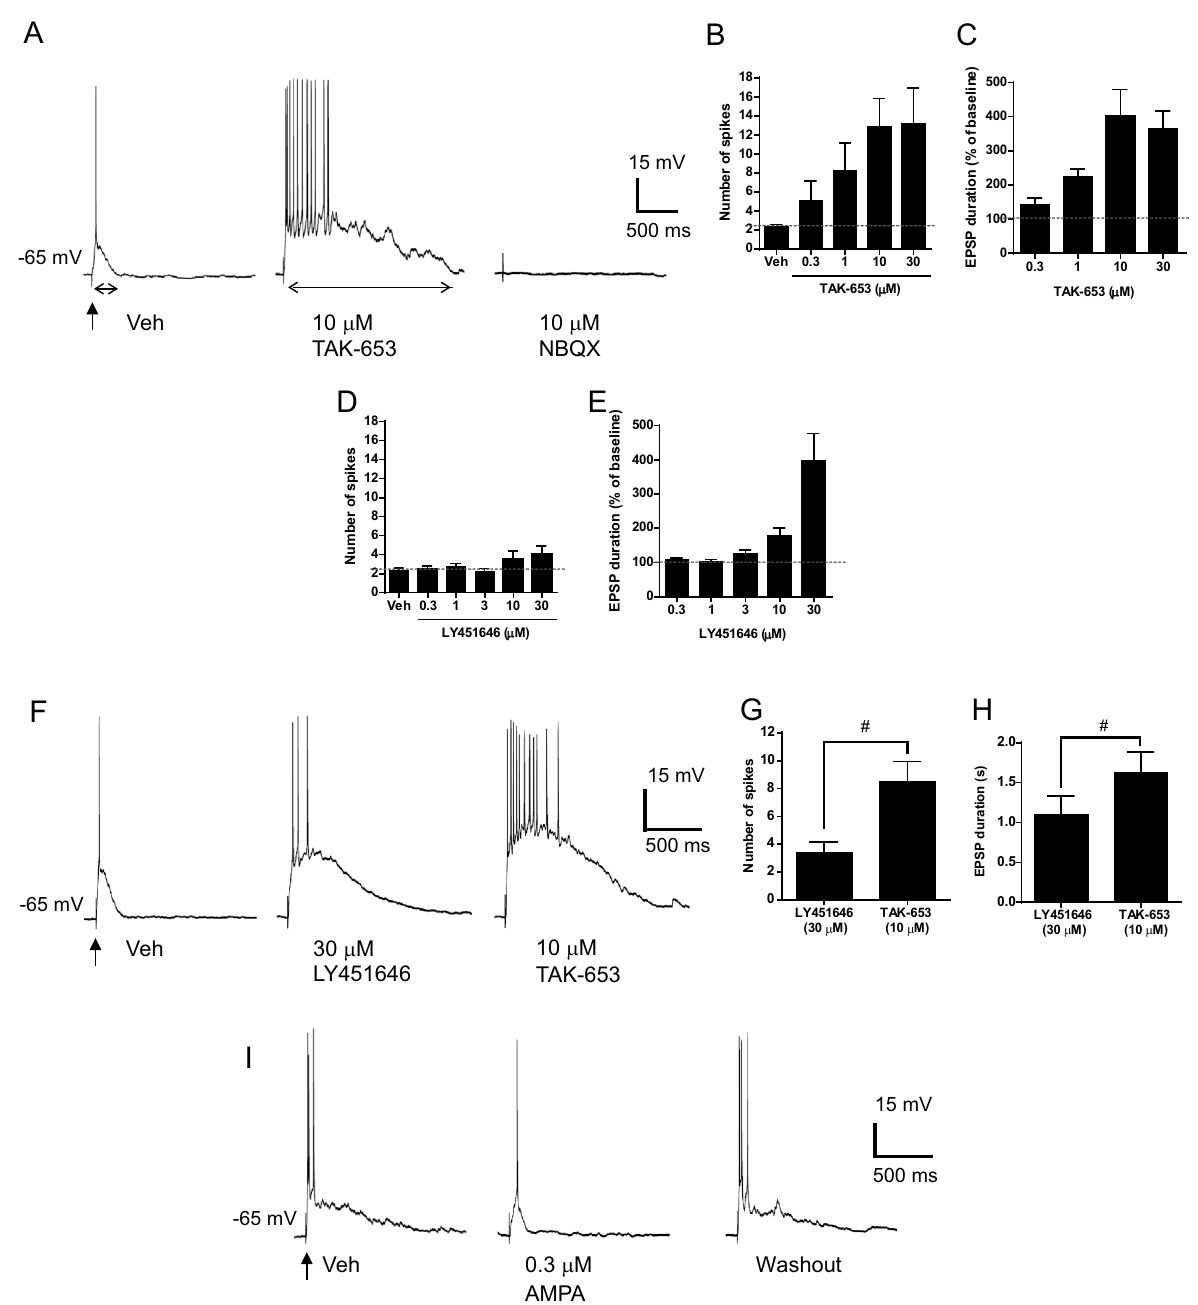
Figure 6. Effect of TAK-653, LY451646, and AMPA on AMPA-R-mediated EPSPs in prefrontal cortical slice. ( A ) In the presence of bicuculline (20 μM), CGP52422 (10 μM), and APV (50 μM) to block GABA A and B and NMDA receptors, respectively, single stimulation of glutamatergic afferents to PFC pyramidal neurons evoked polysynaptic EPSPs to induce action potential spiking. Addition of 10 μM TAK-653 for 10 min enhanced the suprathreshold response, resulting in the prolongation of action potentials trains. This response was abolished by the AMPA receptor antagonist NBQX (10 μM). ( B , C ) Effects of TAK-653 on the number of spikes ( B ) and duration ( C ) of AMPA-R-mediated EPSPs. Data were represented as mean ± SEM (n = 6–10). ( D , E ) Effects of LY451646 on the number of spikes ( D ) and duration ( E ) of AMPA-R-mediated EPSPs. ( F ) Addition of 30 μM LY451646 for 10 min enhanced the suprathreshold response. Perfusion changes from LY451646 to TAK653 caused further augmentation of spike number. ( G , H ) Effects of TAK-653 after removal of LY451646 on the number of spikes ( G ) and duration ( H ) of AMPA-R-mediated EPSPs. Data were represented as mean ± SEM (n = 6–9). Statistical significance between LY451646 and TAK-653 was determined by a paired t test with significance set at # P ≤ 0.05. ( I ) Application of 0.3 μM AMPA for 5 min diminished the suprathreshold response (n =